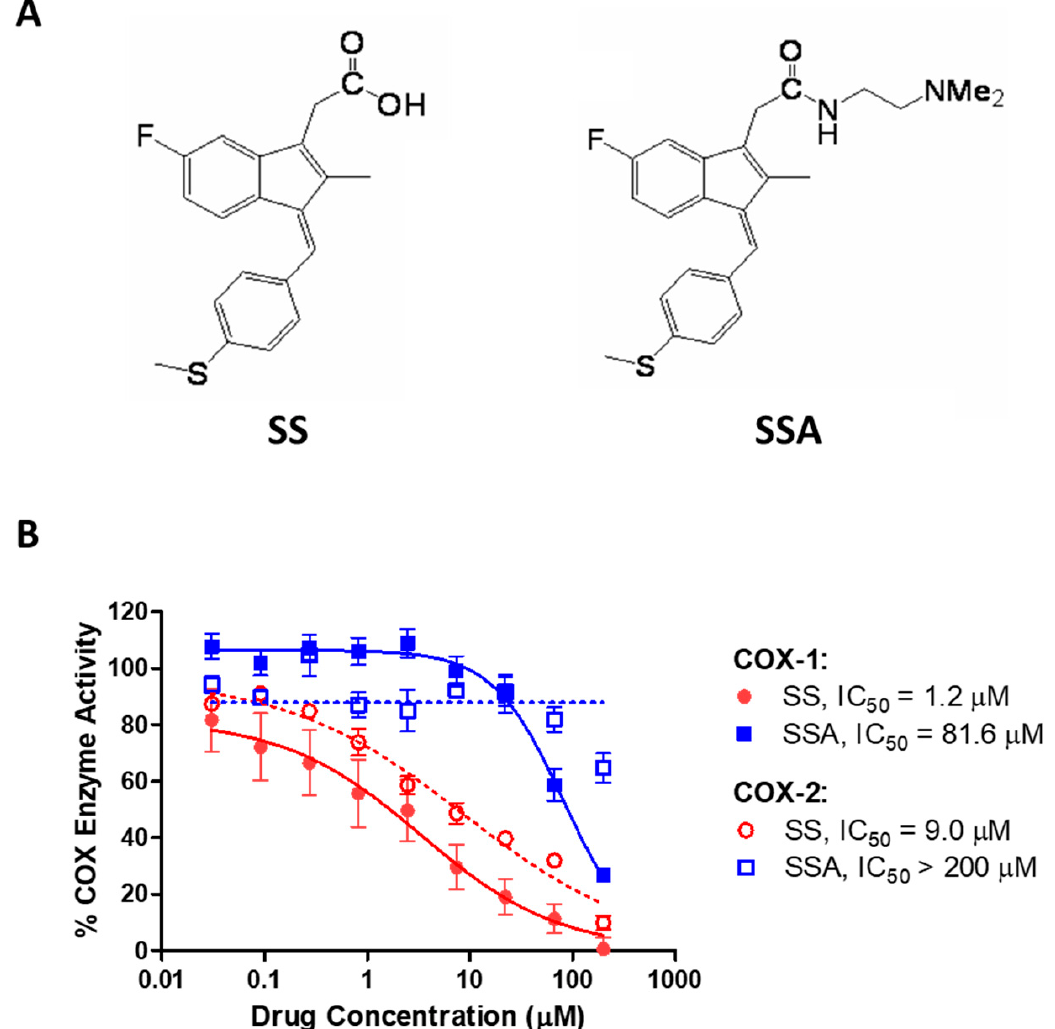
Figure 1. Comparison of sulindac sulfide (SS) and sulindac sulfide amide (SSA). ( A ) Structures of the parent compound SS (left) and the novel dimethylethyl amide derivative SSA (right). ( B ) Inhibitory activity of SS ( ● , ○ ) and SSA ( , ) against purified COX-1 (solid lines) and COX-2 (dashed lines) enzymes.